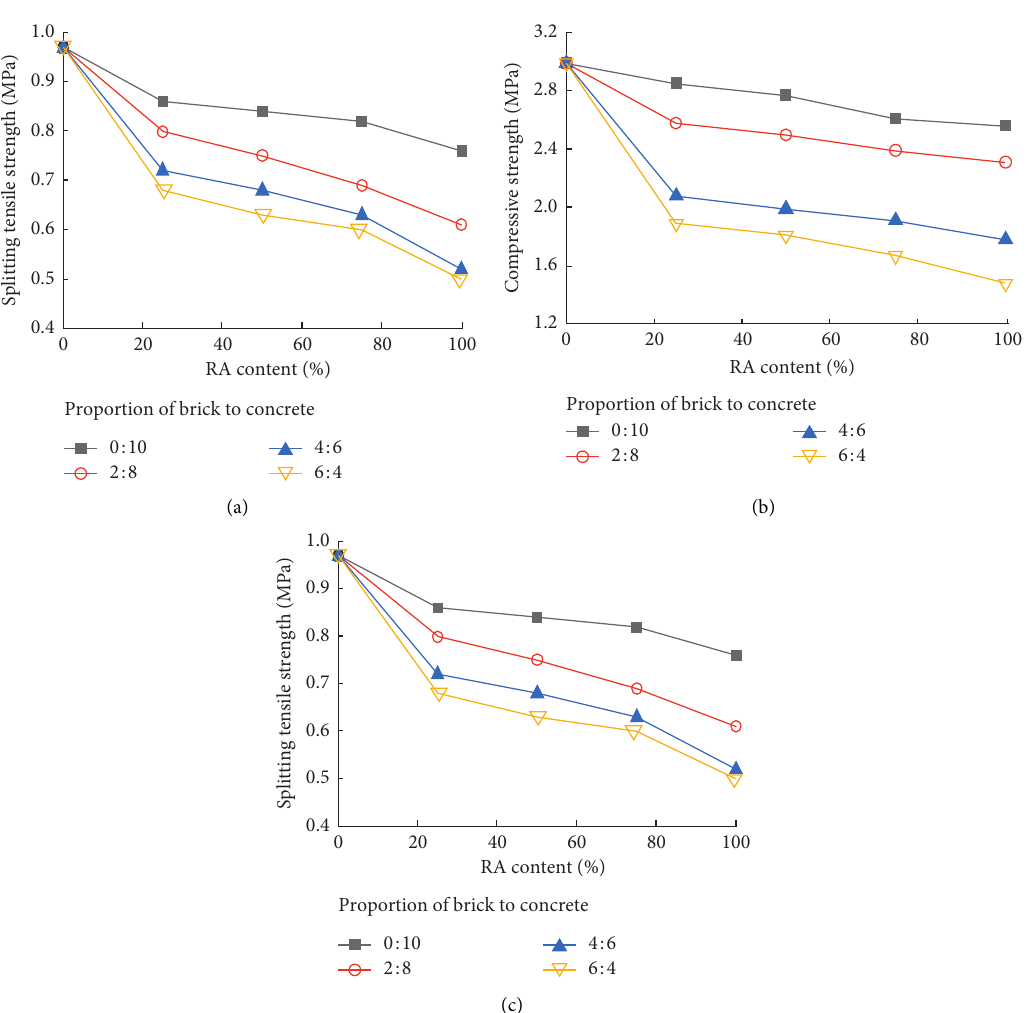
Figure 7: Mechanical test results of recycled asphalt mixtures. (a) Compressive strength. (b) Resilient modulus. (c) Splitting tensile strength.